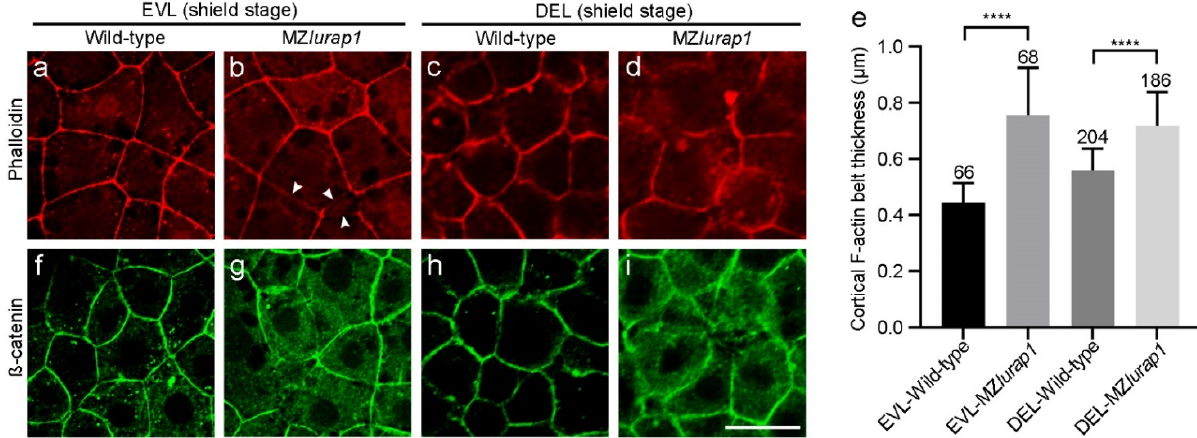
Figure 6. Disrupted cortical F-actin organization in the blastoderm of MZ lurap1 mutant embryos. ( a ) Thin cortical F-actin belt is tightly organized in EVL cells of wild-type embryos. ( b ) Slightly diffuse and disrupted (arrows) cortical F-actin belt in EVL cells of MZ lurap1 mutant embryos. ( c ) Loosely organized cortical F-actin in DEL cells of wild-type embryos. ( d ) Strongly diffuse and disrupted cortical F-actin in DEL cells of MZ lurap1 mutant embryos. ( e ) Statistical analyses of cortical F-actin belt thickness. Data were obtained using 3 embryos from independent experiments in each condition. Numbers on the top of each column represent total cells examined in at least 3 embryos from different experiments. Bars represent the mean value ± s.d. (****, p < 0.0001). ( f ) Regular localization of cortical ß-catenin in EVL cells of wild-type embryos. ( g ) Disrupted and relatively diffuse localization of cortical ß-catenin in EVL cells of MZ lurap1 mutant embryos. ( h ) ß-catenin localization in DEL cells of wild-type embryos. ( i ) Strongly disrupted ß-catenin and diffuse localization in DEL cells of MZ lurap1 mutant embryos. Scale bar: 20 µm.